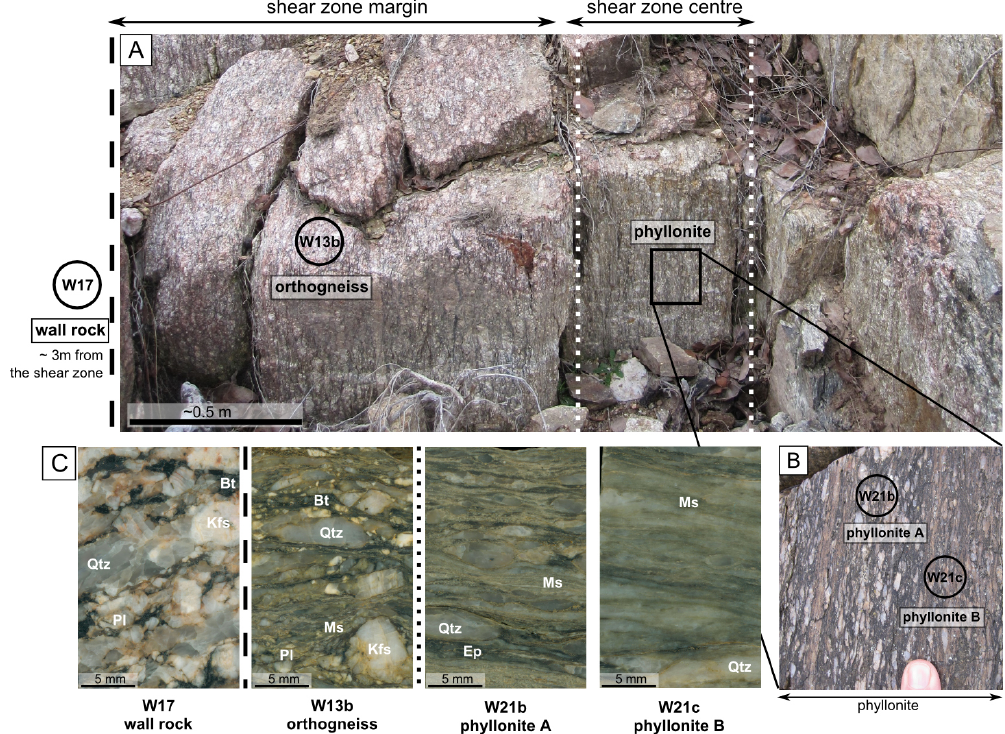
Figure 2. Outcrop and hand specimens. (a) Photo of the studied outcrop showing the different shear zone domains and collection sites of four studied representative samples (W17; W13b; W21b; W21c), which were further used for all the quantitative analysis; (b) fine-scale alternation between phyllonite A and phyllonite B in the central part of the shear zone; (c) sequence of representative samples collected in a transect across the shear